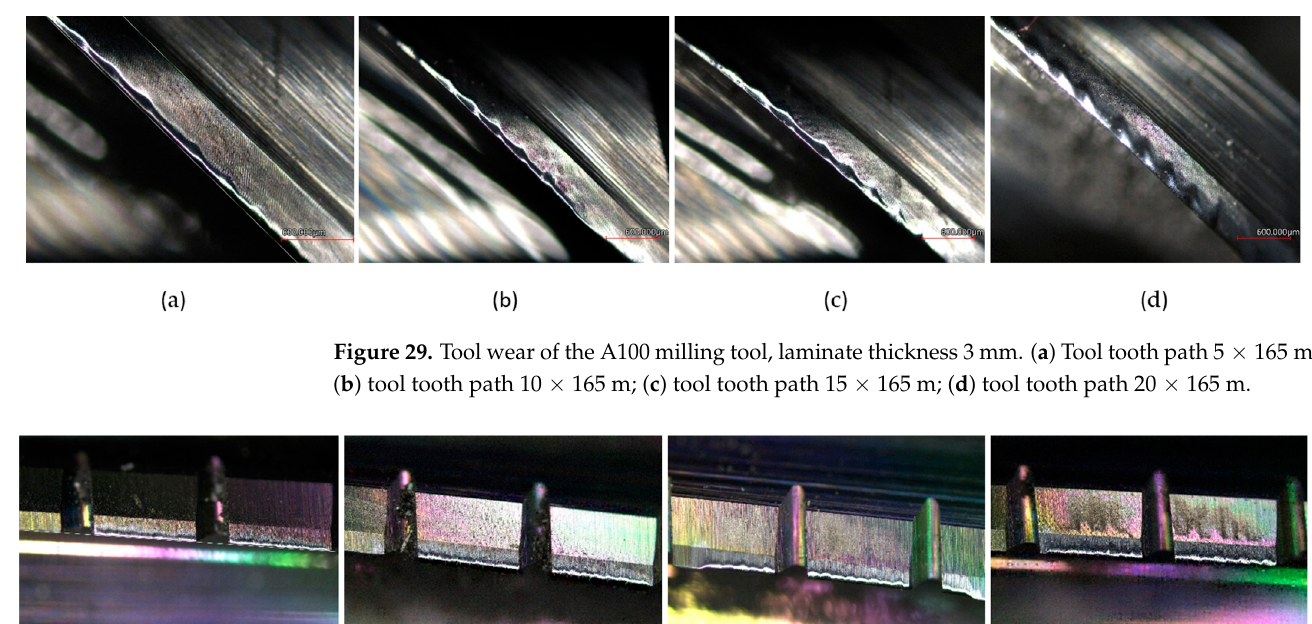
Figure 28. Tool wear of the G550 milling tool, laminate thickness 3 mm. ( a ) Tool tooth path 5 × 165 m; ( b ) tool tooth path 10 × 165 m; ( c ) tool tooth path 15 × 165 m; ( d ) tool tooth path 20 × 165 m.